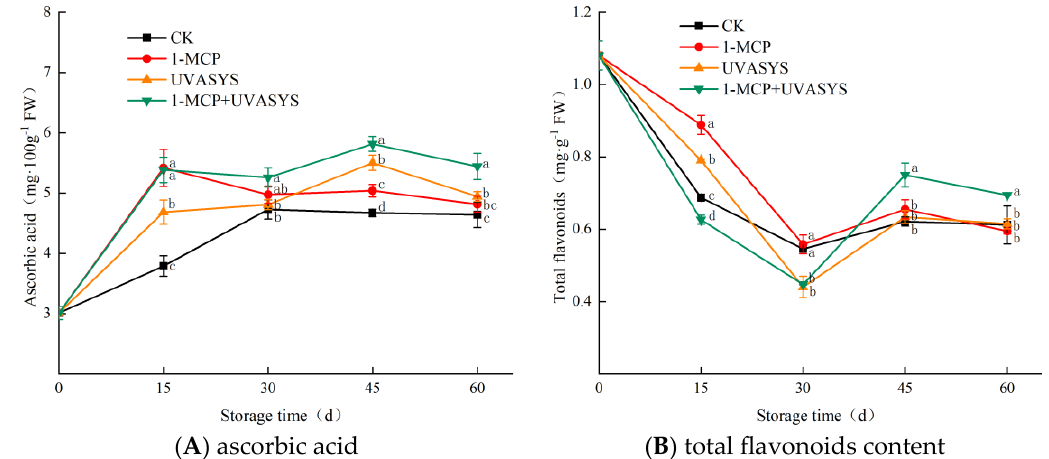
Figure 5. Effects of 1-MCP and UVASYS treatments on the contents of ascorbic acid ( A ) and total flavonoids ( B ) in bamboo shoots during storage. Each data point represents an average ± standard error ( n = 3). Different letters indicate significant differences among treatments for each sampling time at p < 0.05.